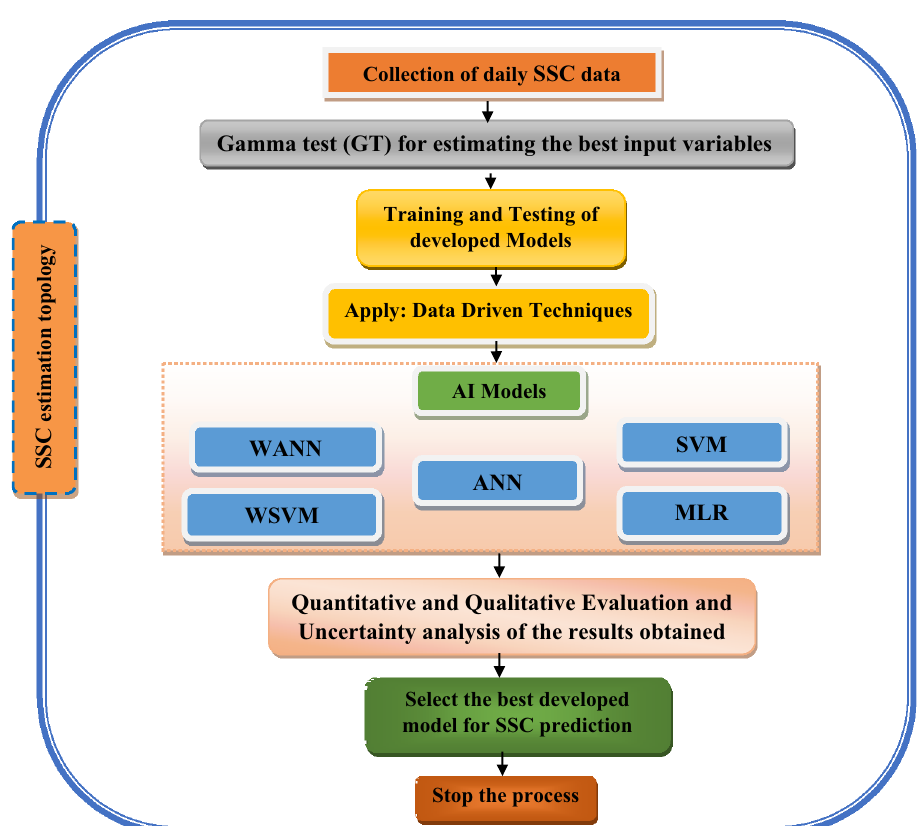
Fig. 6 Flowchart of SSC estimation methodology in the study